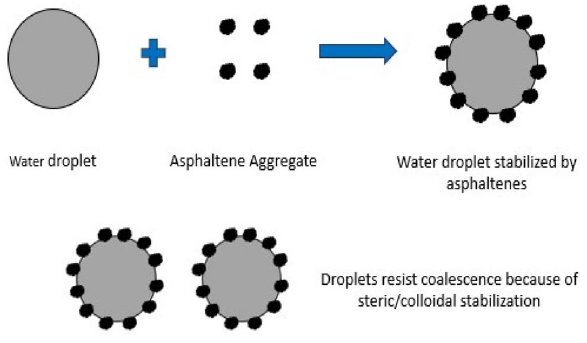
Fig. 7 Molecular structure of asphaltenes suggested by López-Chávez et al.